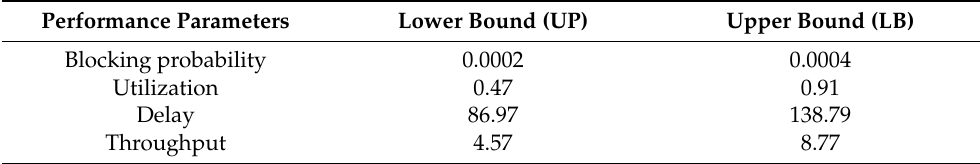
Table 5. The 95% confidence interval